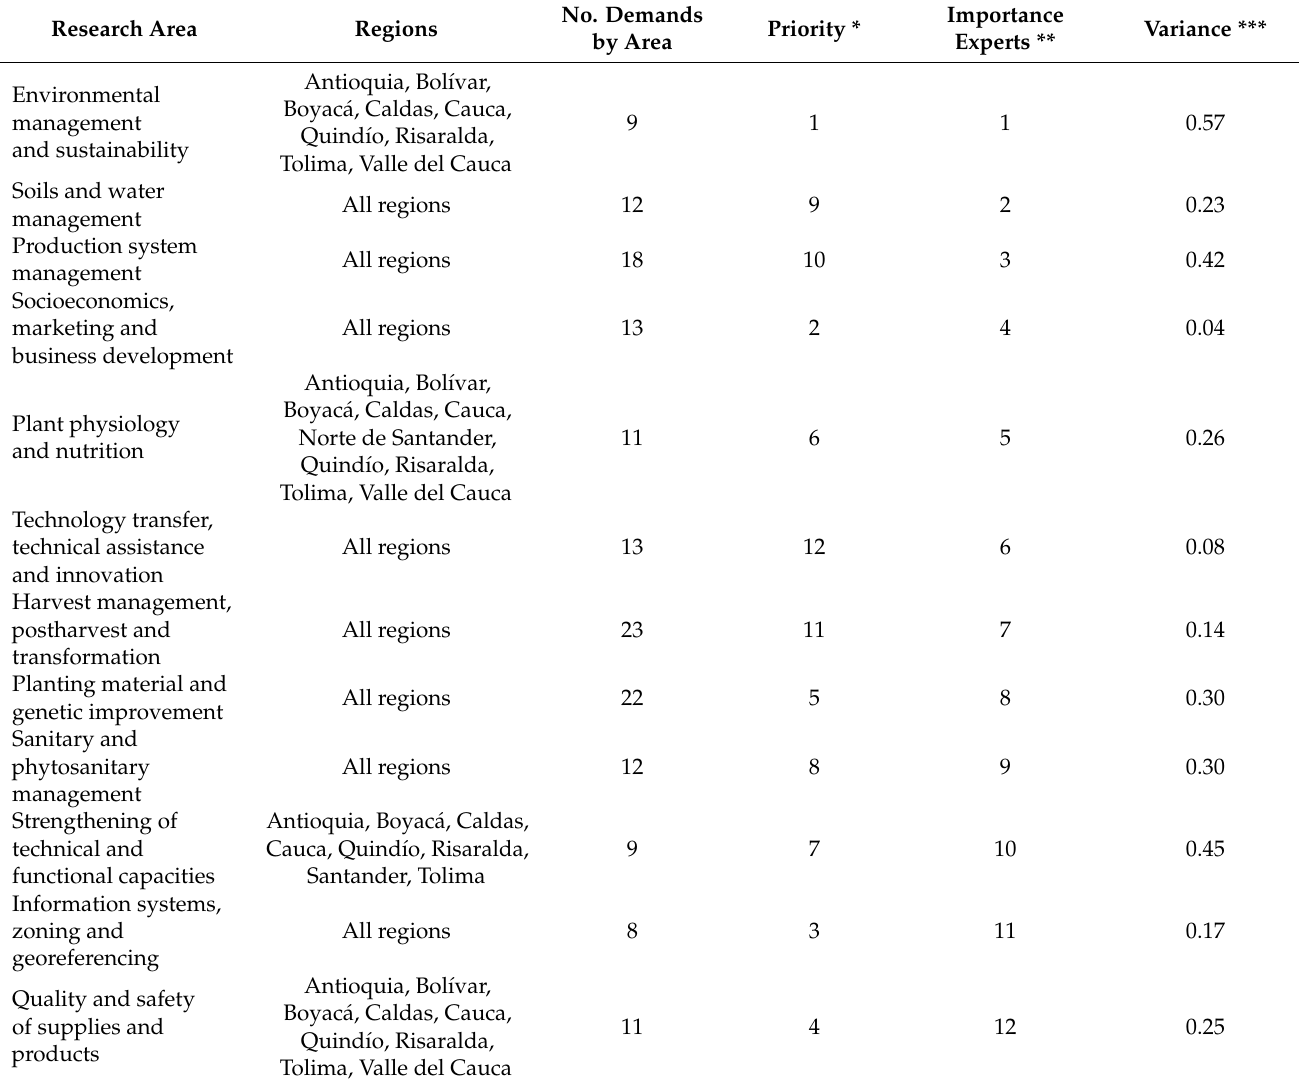
Table 1. Technological demands to avocado value chain in SIEMBRA, organized by importance according to expert